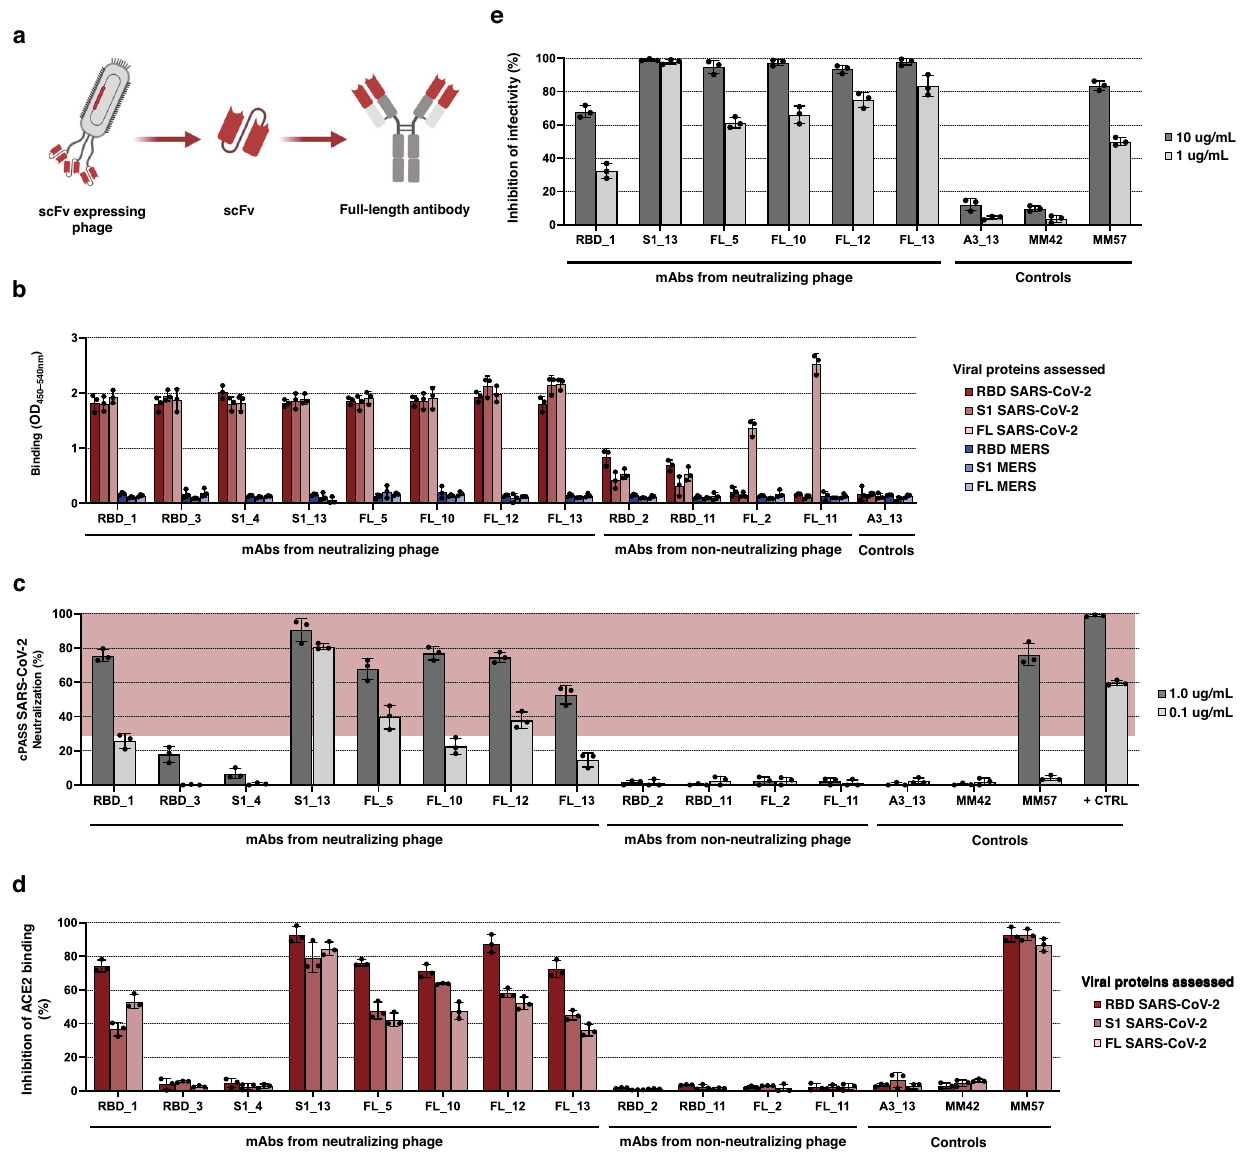
Fig. 4 | Characterization of converted full-length SARS-CoV-2 antibodies. a Schematic of relationship between scFv-expressing phage and full-length anti- bodies. Createdwith BioRender.com. b Speci fi city of full-length antibodiesgrafted from validated scFv-expressing phage. Wells pre-coated with RBD, S1 or FL spike proteins from SARS-CoV-2 or MERS were incubated with converted antibodies. A3_13, which binds to HLA-A3, serves as a negative control for the ELISA. c Measuring neutralization with cPASS assay. Red shaded region represents ≥ 30% neutralization and is de fi ned as detection of SARS-CoV-2 neutralizing activities. MM42, a non-neutralizing negative control mAb. MM57, a neutralizing positive